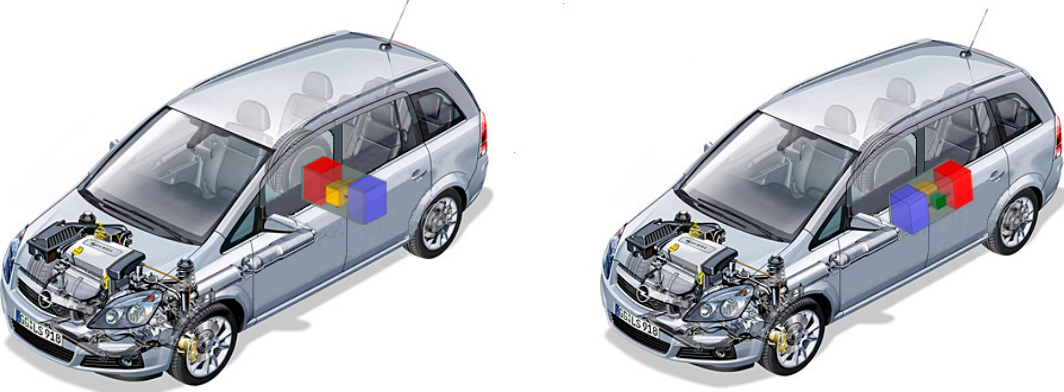
Figure 10. Possible allocation of the ORC plant inside the vehicle.